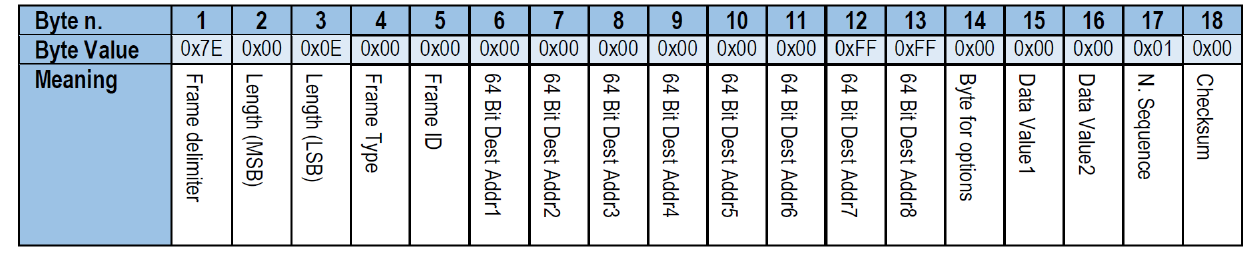
Figure 3. Broadcast command frame sent from the Coordinator Node to the Smart Measuring Nodes.